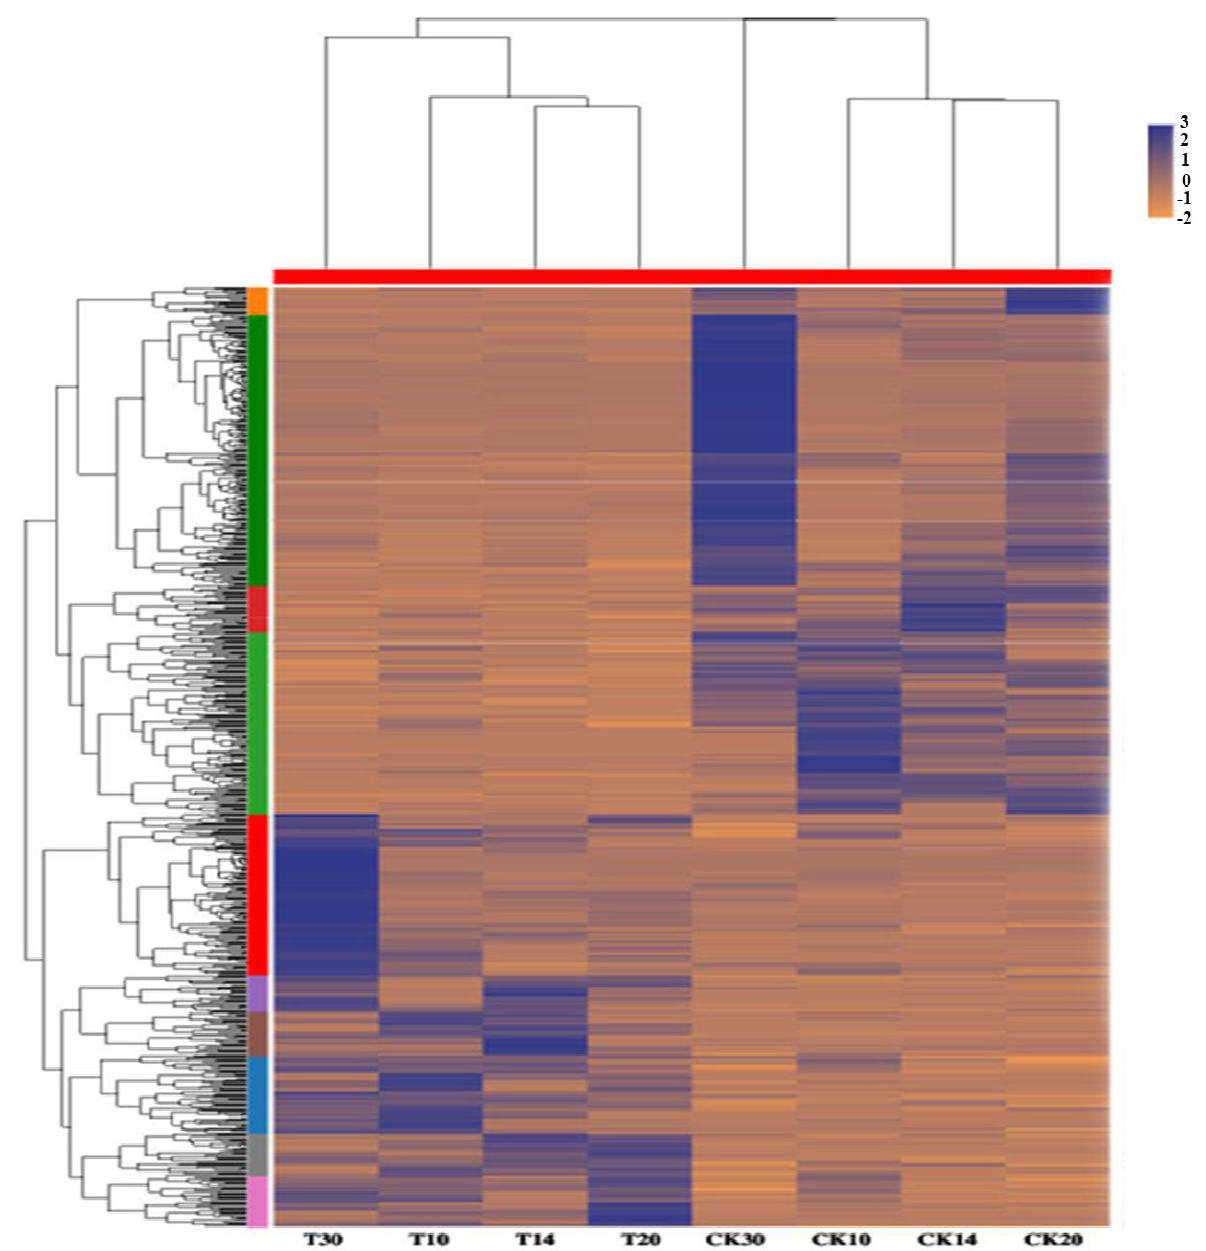
Figure 11. Hierarchical clustering analysis of all DEGs of all collected samples T10, T14, T20, T30, CK10, Ck14, Ck20, and CK30. A total of 696 genes were identified at p < 0.05 (ANOVA and Tukey HSD test); means ± SD. The color key represents the FPKM (Fragments per Kilobase of exon per Million fragments mapped)-normalized log2 transformed counts. Blue and Brown represent high and low expression, respectively. Each row represents a gene, with further detail given in Supplementary File S5.